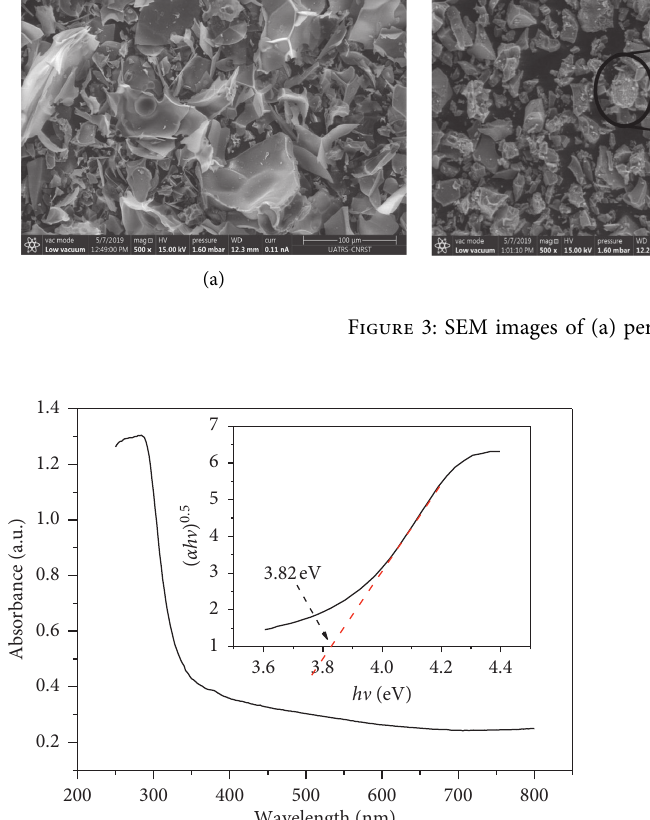
Figure 4: UV-visible absorbance spectra and the corresponding Tauc plot (inset) of the perlite-based geopolymer.